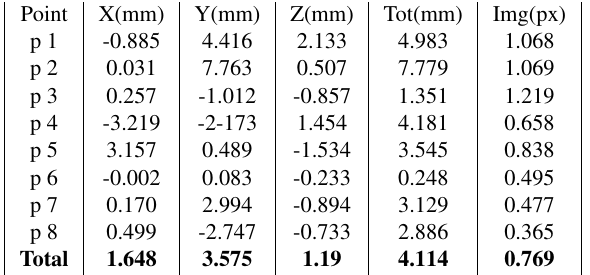
Table 2. Check points precision report.